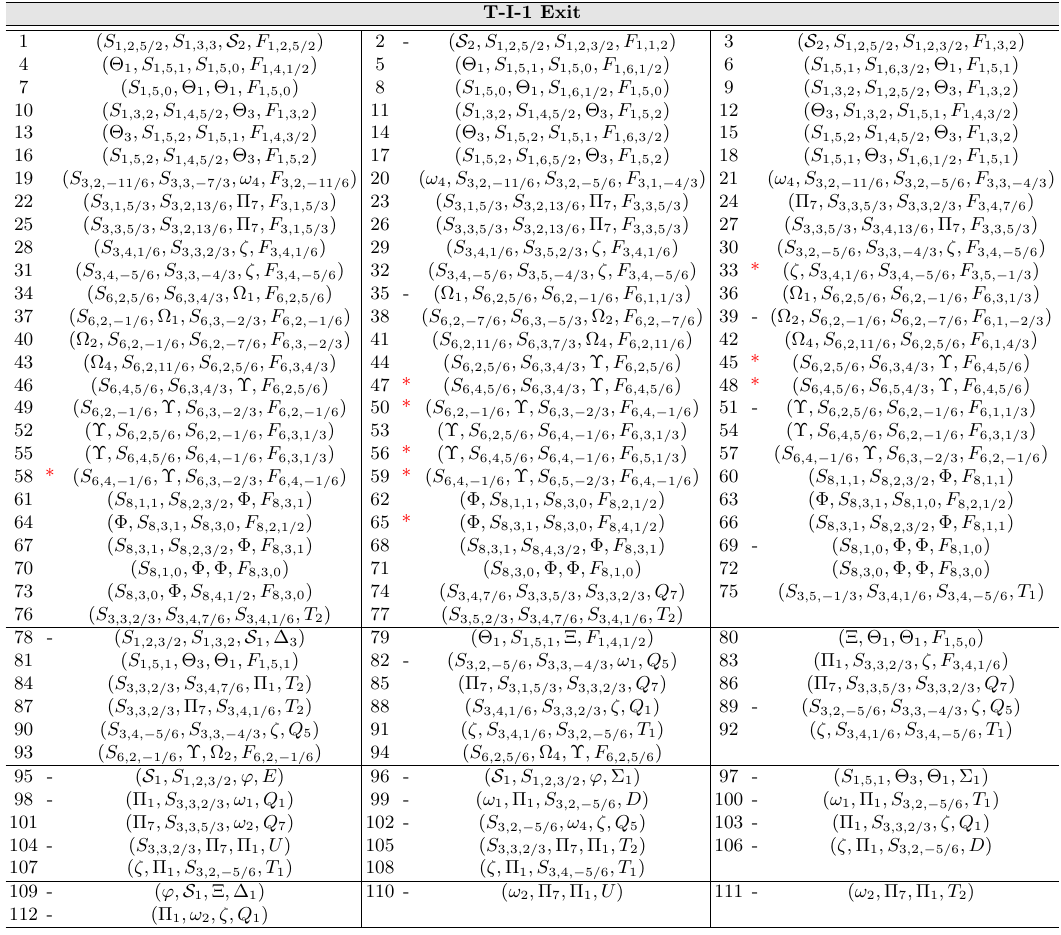
Table 1: TI-1 models with scalar and fermionic exits. The four main cells represent the models with 1,2,3,4 exits. The * Table 5 . T-I-1 models with scalar and fermionic exits. The four horizontal divisions represent the ( ) represents the models where: One of the Landau pole scales is very low, i.e Λ 1 or λ 2 or Λ 3 < 100 TeV (All Landau − pole scales, larger than m NP , are very large Λ 1 , 2 , 3 > 10 15 GeV) models with 1, 2, 3 and 4 exit fields. The * and “ − ” represent the models where one of the Landau pole scales is very low, i.e. Λ 1 , 2 , 3 < 100 TeV, and where there is no Landau pole up to 10 15